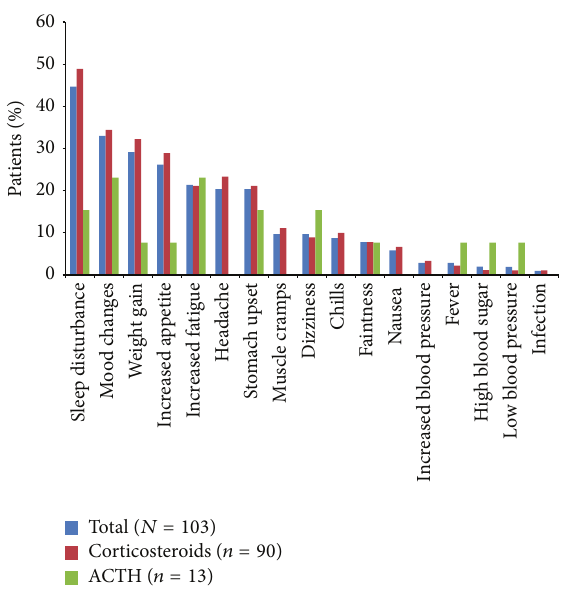
Figure 2: Adverse events associated with last relapse treatment. ARMS: Assessing Relapse in Multiple Sclerosis. Figure 3: Adverse events with treatment for current relapse. ACTH: adrenocorticotropic hormone; ARMS: Assessing Relapse in Multiple